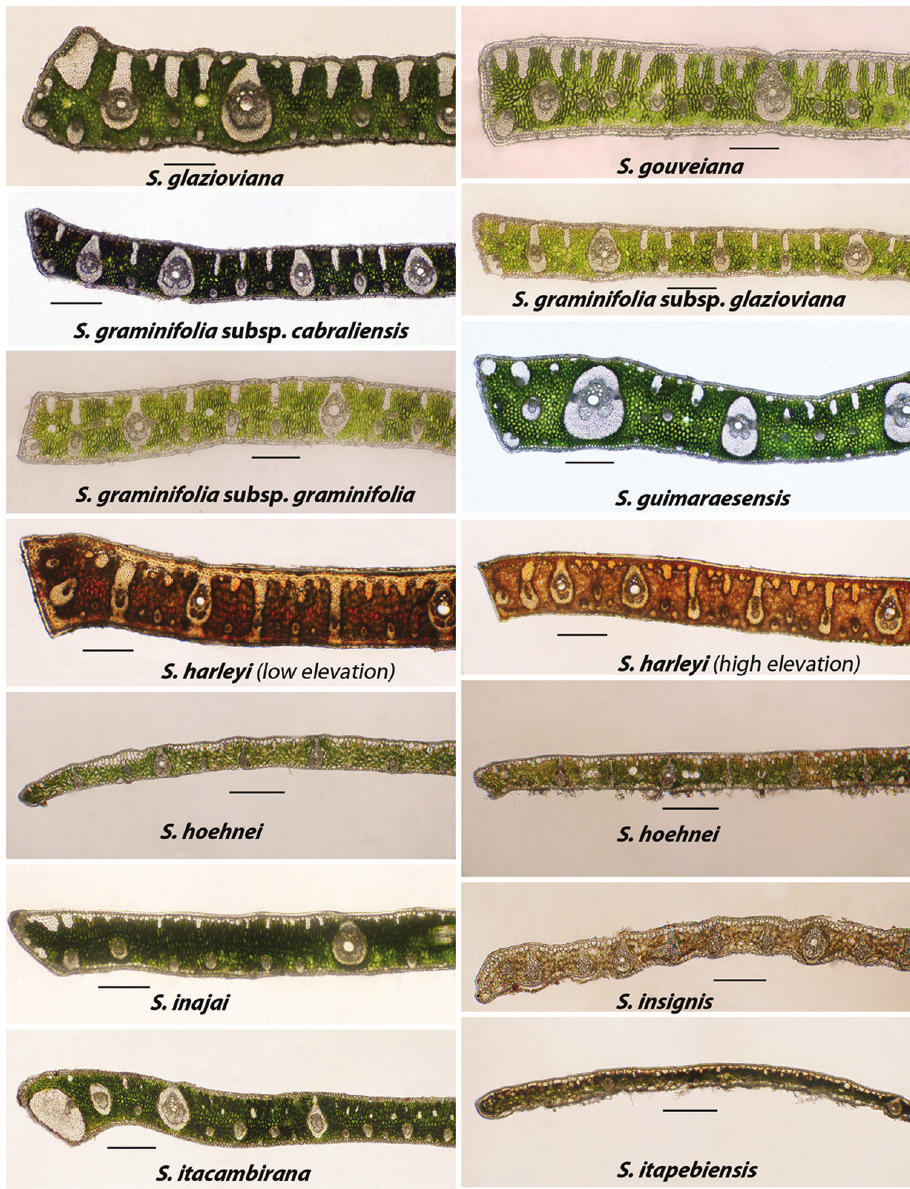
Figure 5. Alphabetically arranged marginal leaflet transections. Syagrus glazioviana to S. itapebiensis . Note variation in S. harleyi and S. hoehnei . Bar scale = 0.25